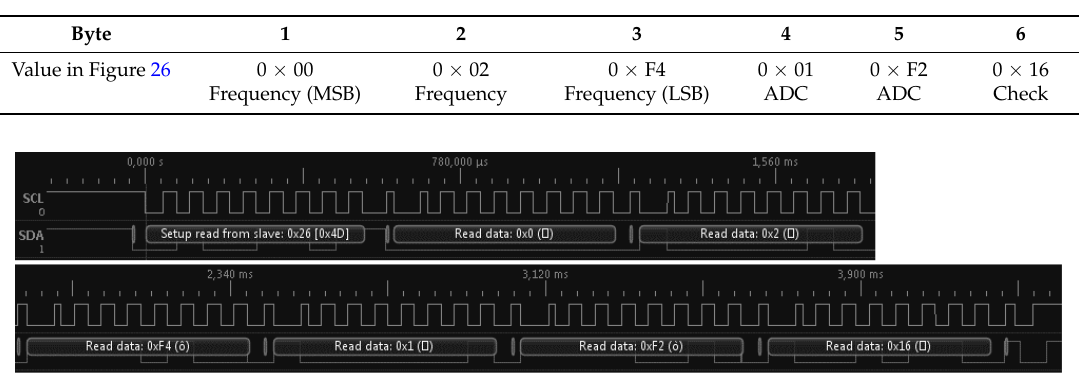
Table 4. Bytes received after a sample reading request.